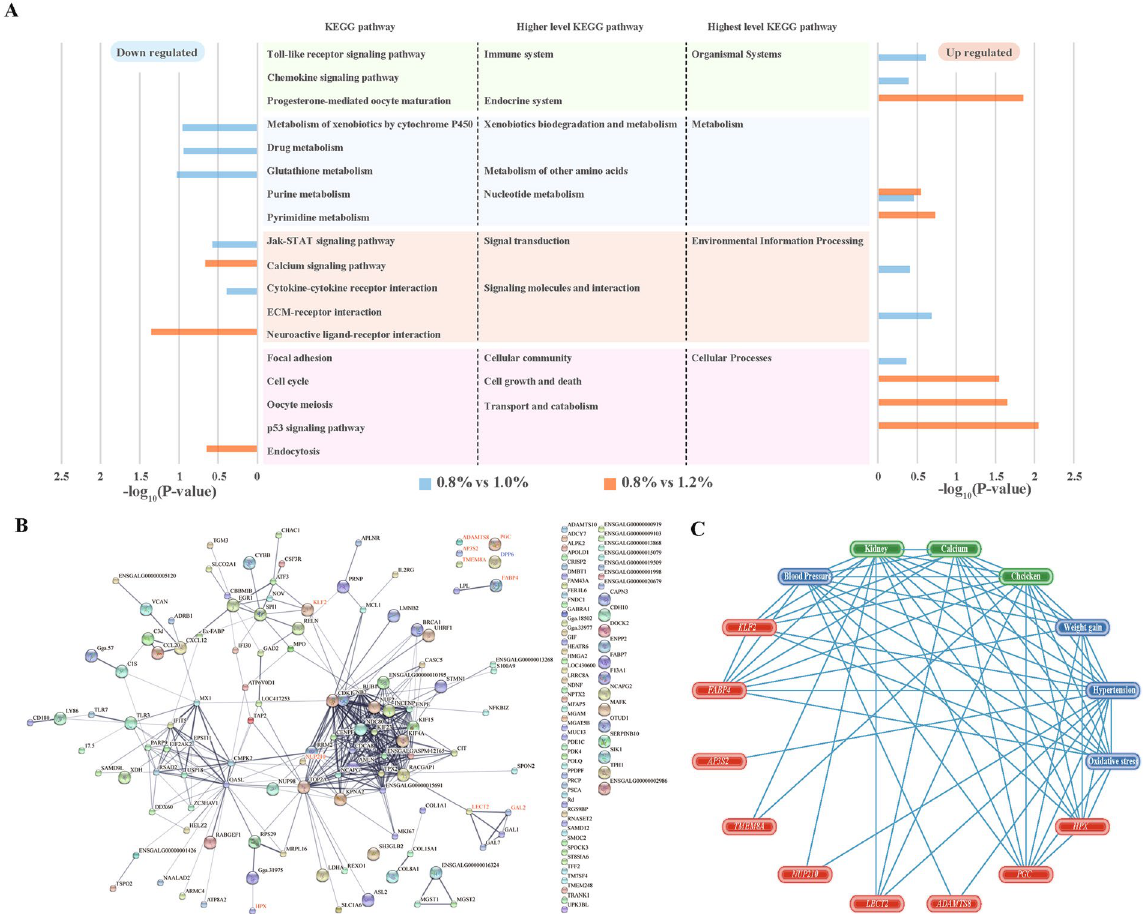
Figure 3. Enriched KEGG pathways, protein/protein interaction network, and co-occurrence analysis of DEGs identified between kidney samples from broiler chickens fed diets containing 0.8, 1.0, and 1.2% Ca using both cufflinks and edgeR. ( A ) KEGG pathway enrichment of DEGs identified using the cufflinks tool between pairs of conditions (0.8 versus 1.0 and 0.8 versus 1.2% Ca). ( B ) Protein/protein interactions of DEGs that were identified using the edgeR/cufflinks as generated by the STRING database. ( C ) Annotation of the co-occurrence of DEGs identified using the edgeR/cufflinks with chicken, kidney, calcium, blood pressure, hypertension, oxidative stress, and weight gain using the COREMINE